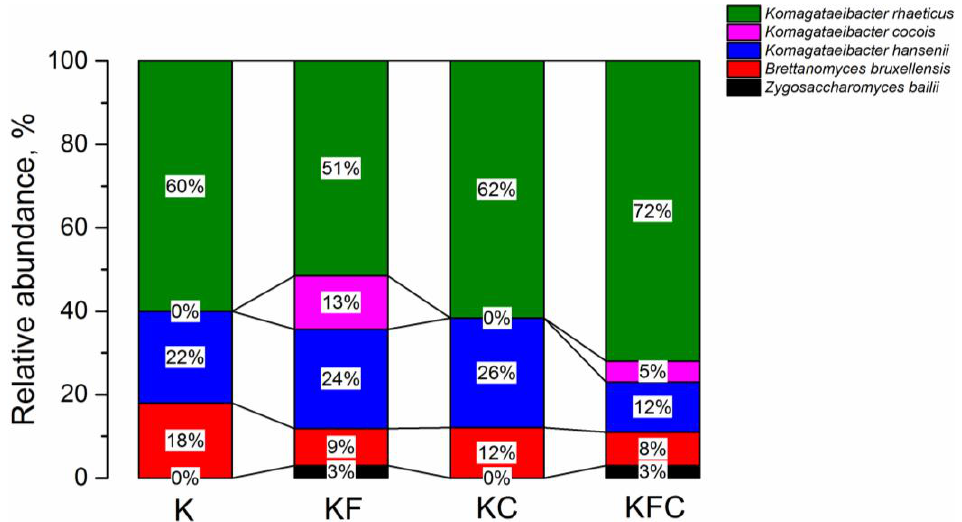
Figure 6. Taxonomic classification of the microbial population of the kombucha samples on the 12th day of fermentation (K — control, KF — kombucha with algae extract, KC — kombucha with lichen extract, KFC — kombucha with a mixture of algae and lichen extracts).